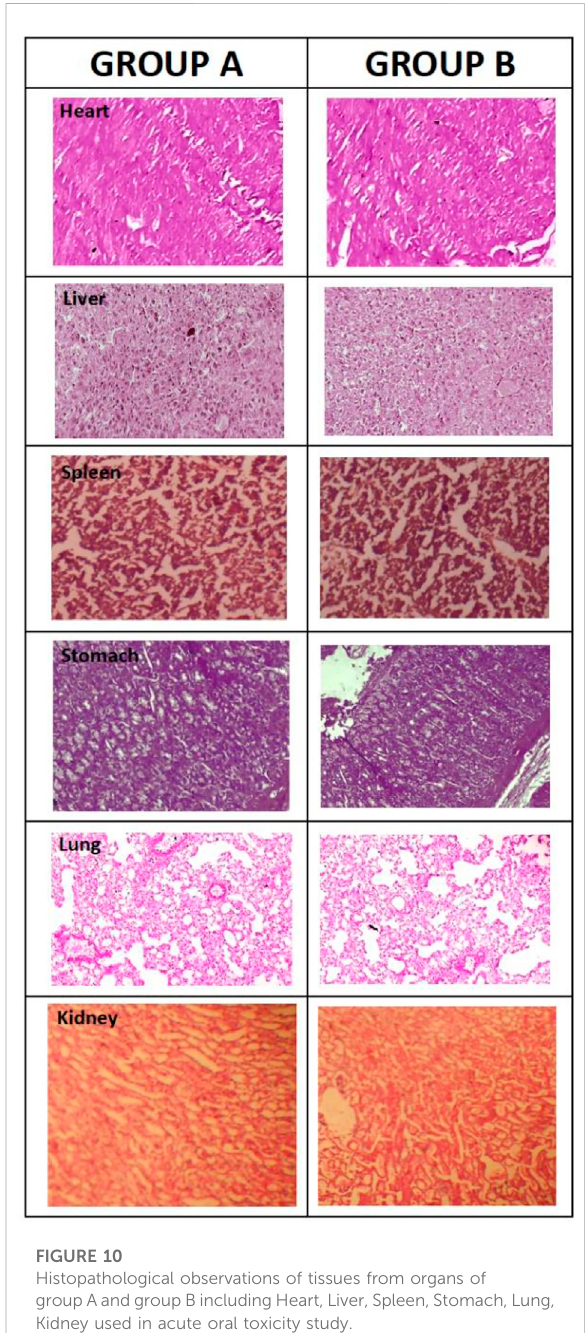
FIGURE 10 Histopathological observations of tissues from organs of group Aand group Bincluding Heart, Liver,Spleen, Stomach,Lung, Kidney used in acute oral toxicity